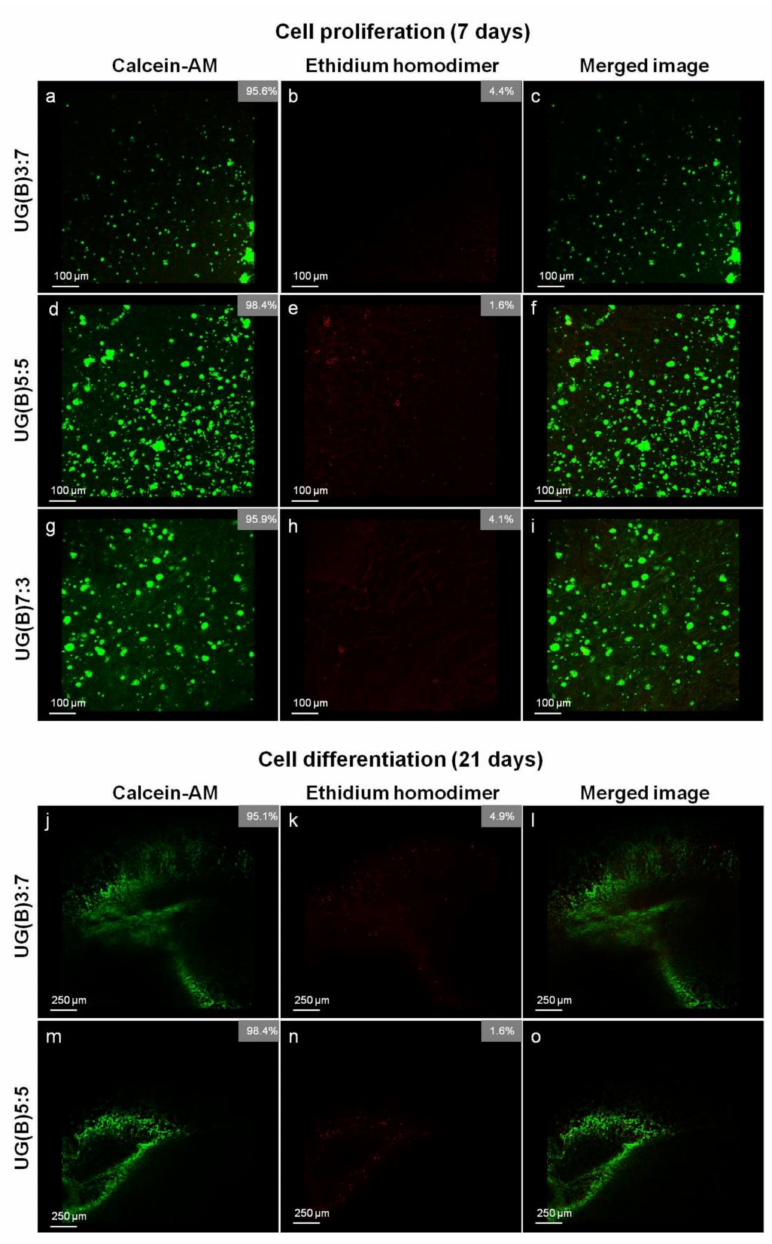
Figure 8. Confocal images of UG(B) sca ff olds seeded with hADMSCs. Live / dead staining with calcein AM / ethidium homodimer showing cell viability of hADMSCs ( a – i ) after 7 days culture and ( j – o ) after 21 days culture in osteogenic medium. The relative cell viability or mortality (%) are denoted in the upper right part of the